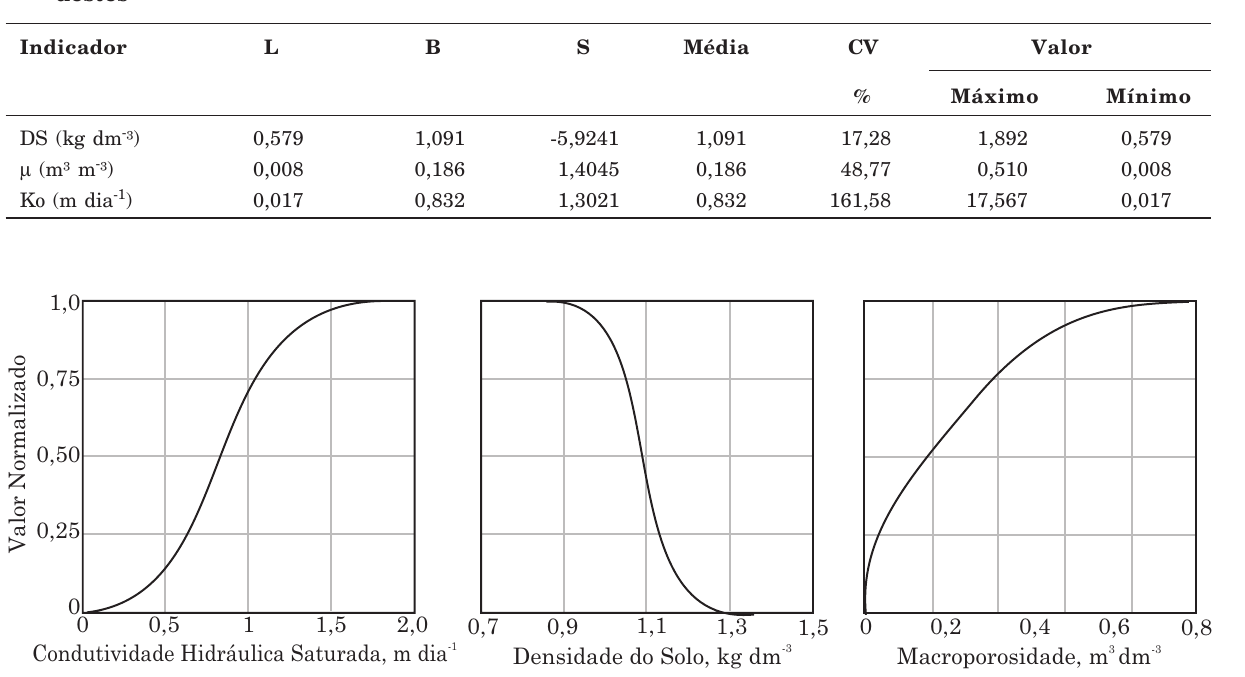
Figura 4. Curvas de normalização para os indicadores do índice de qualidade do solo associado à recarga de água subterrânea (IQS RA ) para a Bacia Hidrográfica do Alto Rio Grande, MG.